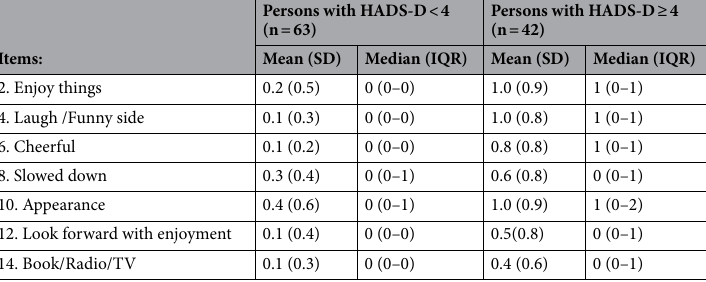
Table 2. Ratings on Hospital Anxiety and Depression Scale-Depression